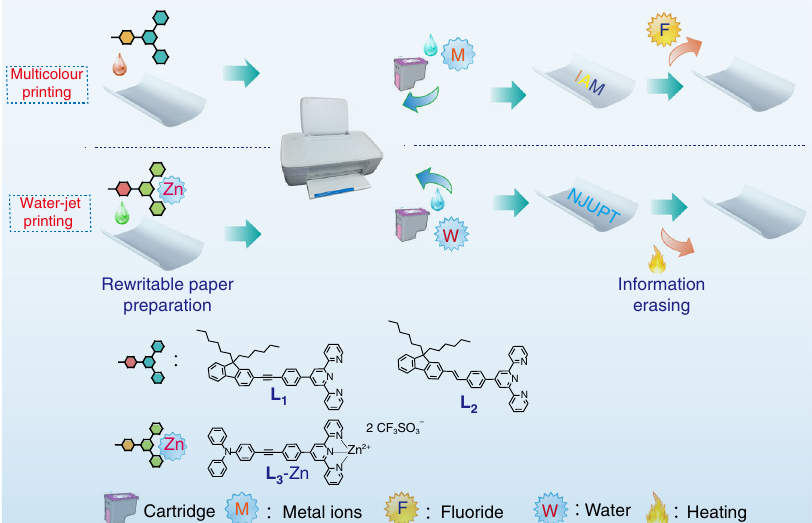
Fig. 1 Schematic illustration of multicolour and water printing. Chemical structures of L 1 , L 2 and L 3 , and the printing and erasing processes for the constructed rewritable